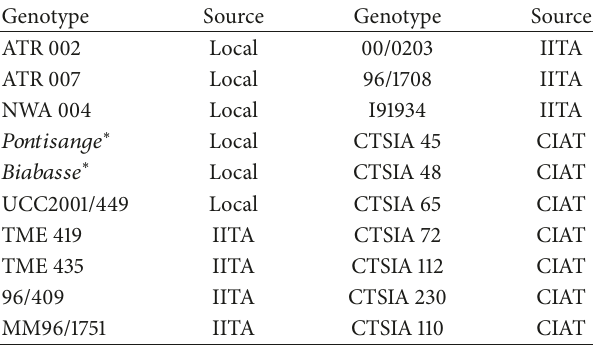
Table 1: List of cassava genotypes used in the